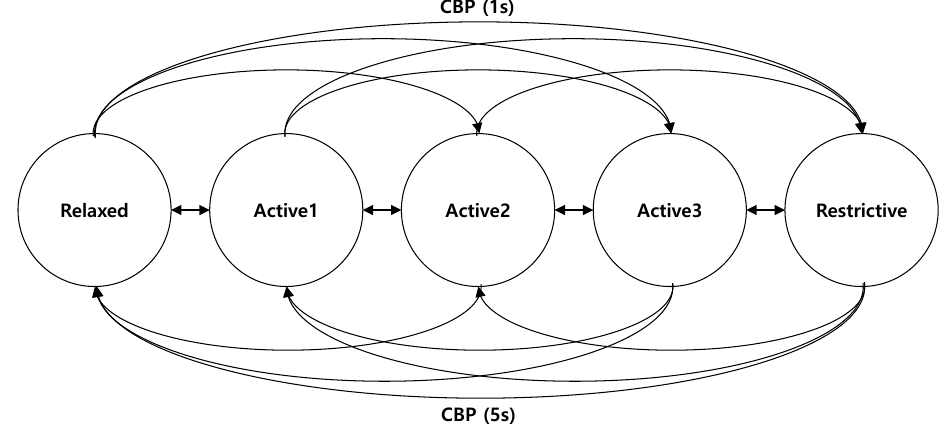
Figure 1. DCC state machine.